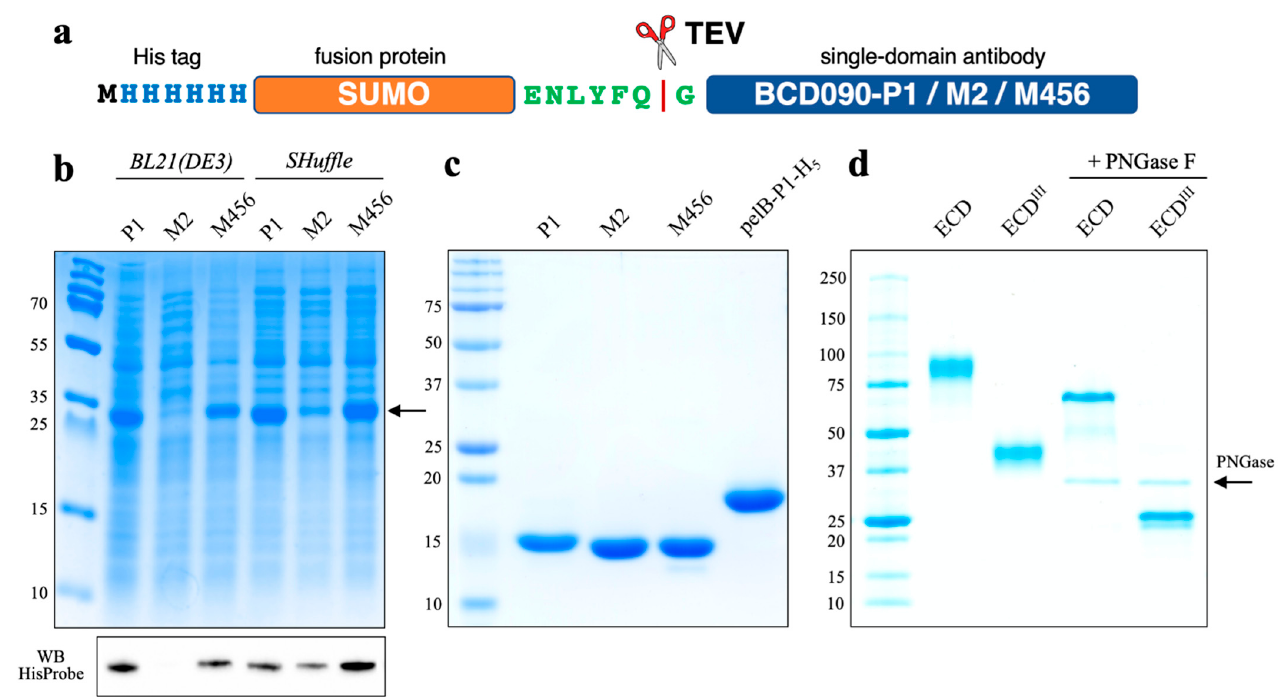
Figure 1. Expression and purification of the anti-ErbB3 single-domain antibodies and ErbB3 receptor fragments. ( a ) Scheme of SUMO fusions used to produce single-domain antibodies; ( b ) SDS-PAGE and Western blot of soluble extracts, the recombinant fusion proteins have MW 27 kDa; BCD090-M2 expressed in soluble form only in SHuffle cells, but not BL21(DE3); ( c ) SDS-PAGE of the purified single-domain antibodies, periplasmically expressed pelB-BCD090-P1-His 5 migrates higher due to the presence of uncleaved pelB leader and histidine tag; ( d ) SDS-PAGE of the purified human ErbB3 extracellular domain (ECD, MW 75 kDa) and the extracellular subdomain 3 (ECD III , MW ~25 kDa); receptor fragments analyzed in the native glycosylated form and after treatment with PNGase